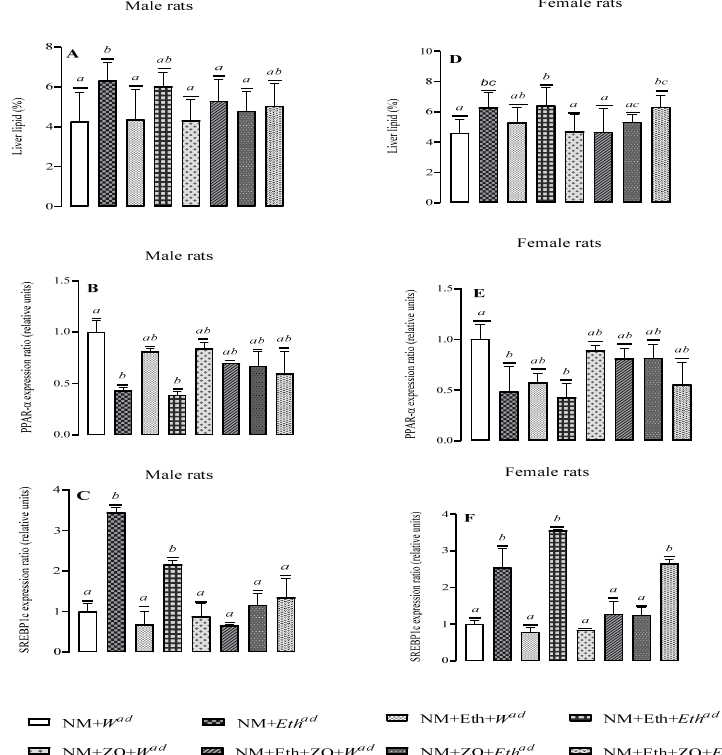
Figure 3. Effect of neonatal orally administered zingerone on liver lipid ( A , D ); PPAR- α and ( B , E ) SREBP1c ( C , F ) gene expression in male and female rats drinking alcohol in adulthood. Data are presented as mean ± sd. a,b = Bars with different letters differ significantly at p < 0.05. Control (NM +